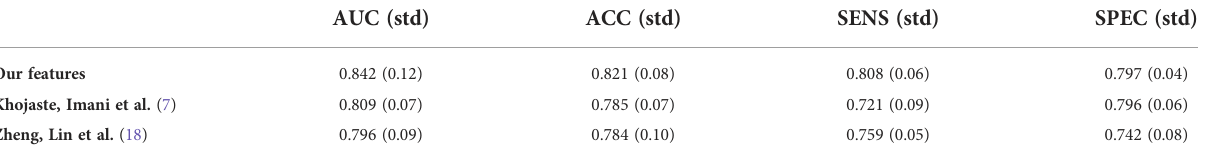
TABLE 5 The classi fi cation results of our features and Zheng and Imani ’ s